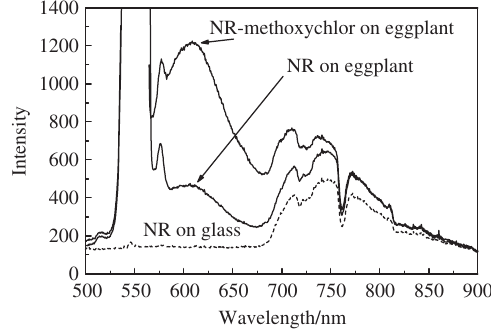
Figure 10 Emission spectra obtained from solid NR on glass (no emission at 605 nm), from solid NR on eggplant (indicating the background emission) and from the NR-methoxychlor complex on eggplant. Analysis is based on the emission at 605 nm, whereas the room-light refl ections are at 700 – 800 nm ( Hassoon and Schechter 2000